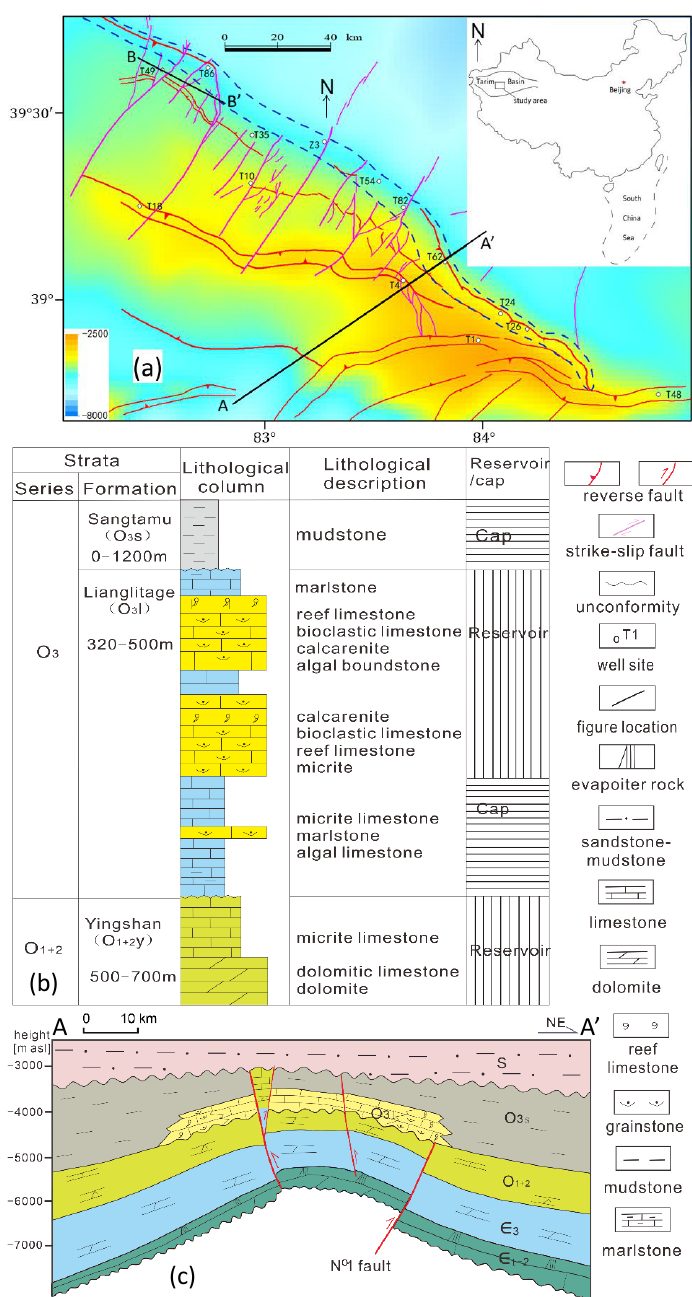
Figure 1. A tectonic sketch of the Ordovician carbonate top ( a ), the Middle-Upper Ordovician strata column ( b ) and the reservoir model of the Upper Ordovician ( c ) in the Central Uplift (revised after References [13,28]).